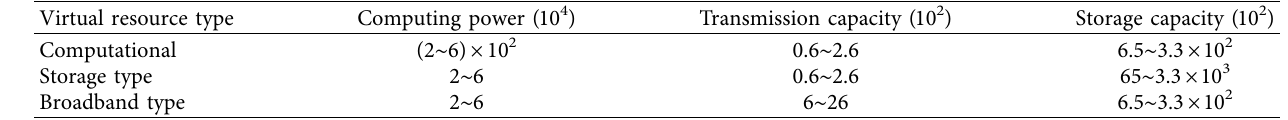
Table 2: Indicators of each node of cloud service virtual resource pool.